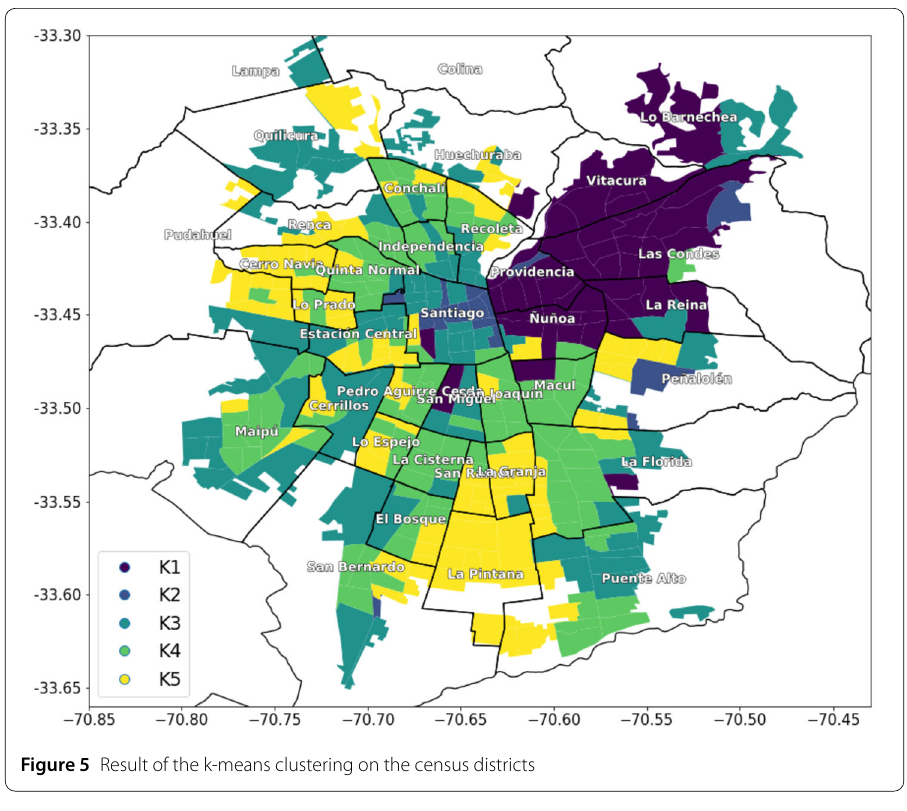
Figure 5 Result of the k-means clustering on the census districts